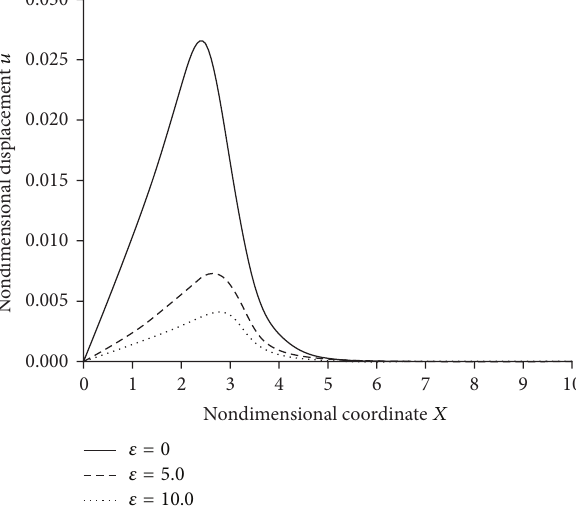
Figure 7: Nondimensional temperature distribution for different 𝜀 values.